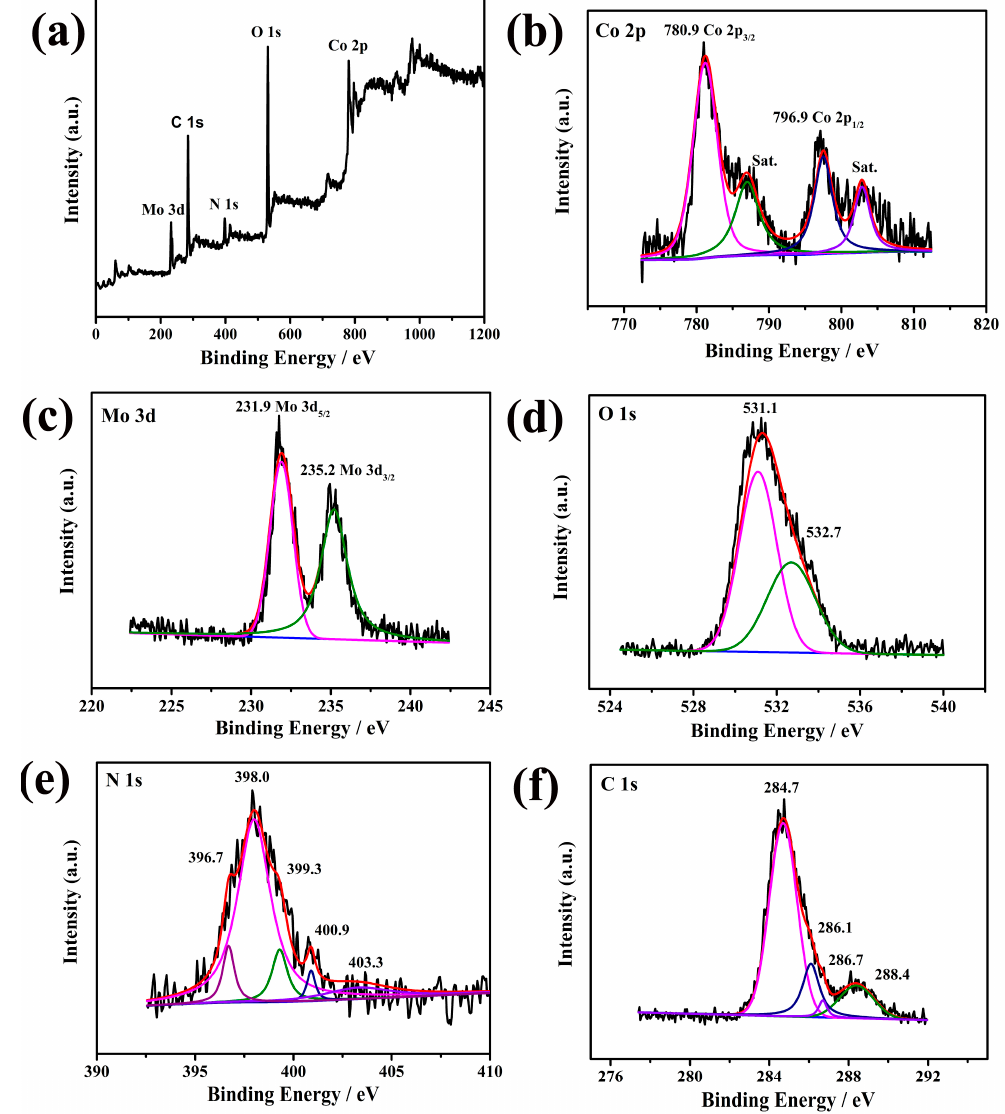
Figure 2 . ( a ) the XPS survey of CoMoO 4 /rGO; ( b ) Co 2p XPS peaks; ( c ) Mo 3d XPS peaks; ( d ) O 1s XPS spectrum; ( e ) N 1s XPS spectrum; ( f ) C 1s peaks XPS.